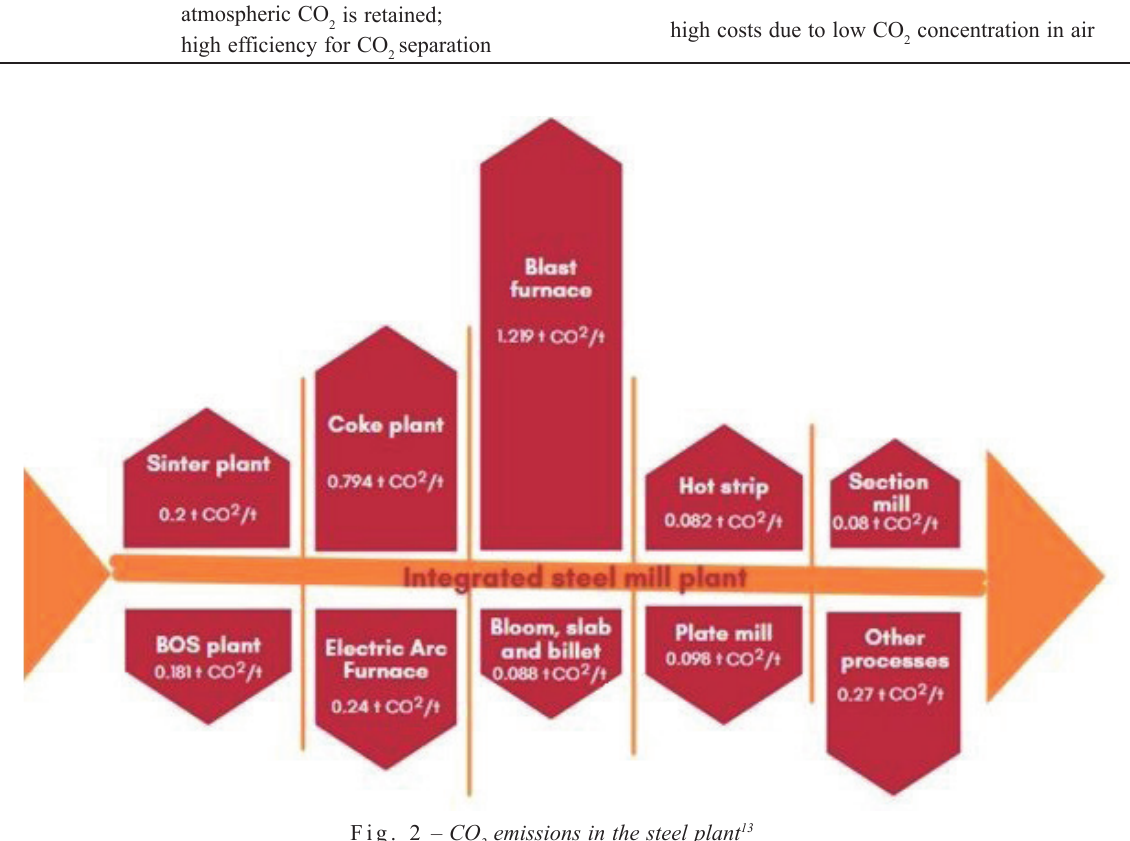
Fig. 2 – CO emissions in the steel plant 2